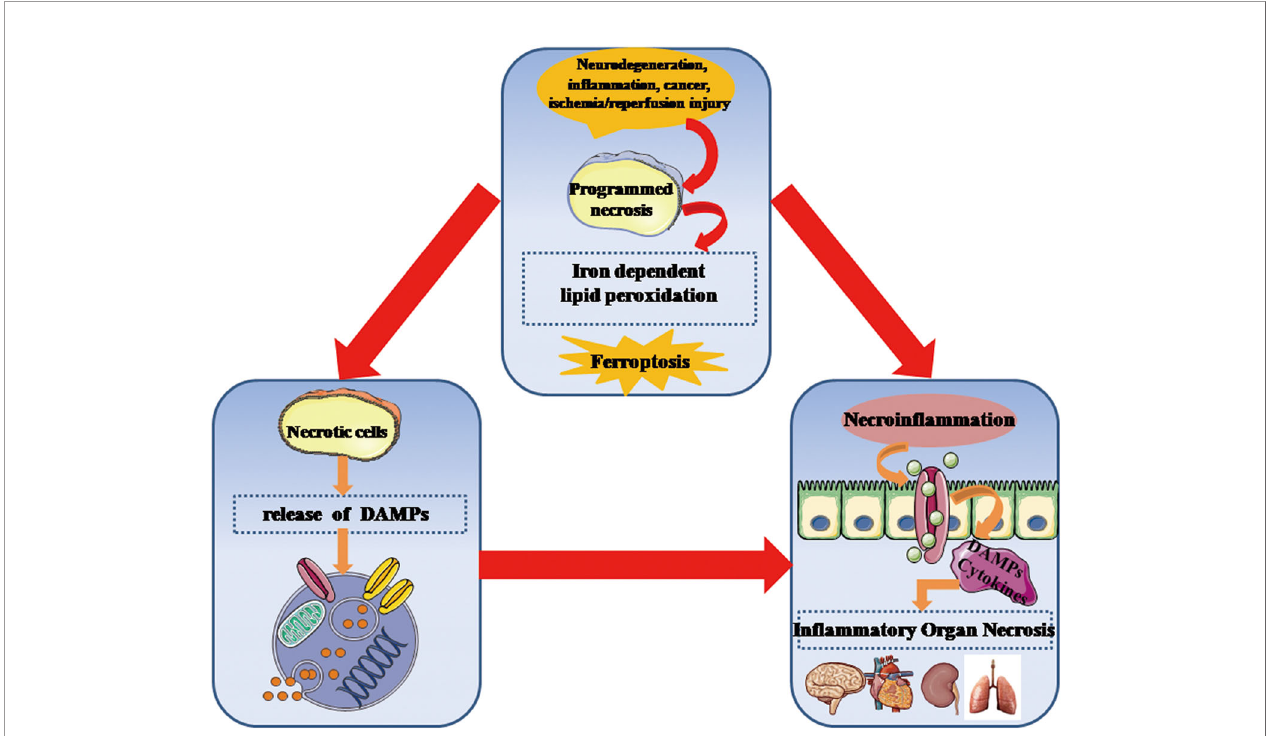
FIGURE 3 | Ferroptosis is critically involved in the development of necroin fl ammatory diseases. Genetically programmed necrosis is initiated by variously systematic stress including oxidation, immunogenic molecules, metabolic disturbance, and ischemia/reperfusion injury. In the setting of oxidative stress, ferroptosis-induced lipid peroxidation and ROS can promote the programmed necrotic cells to release DAMPs as well as in fl ammatory cytokines that stimulate innate immune cells to enhance necroin fl ammatory response. DAMPs, danger-associated molecular patterns; ROS, reactive oxygen